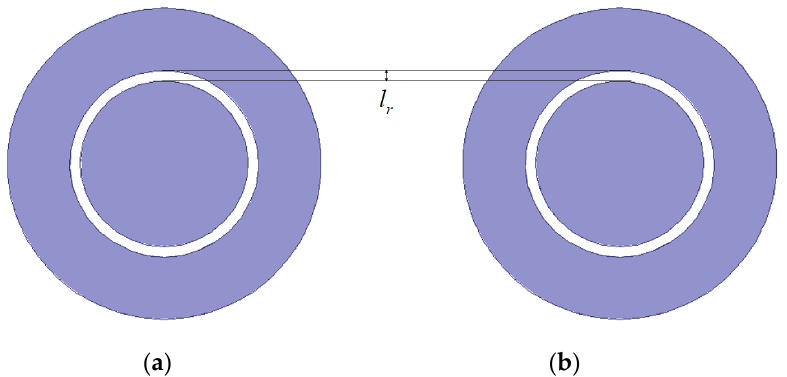
Figure 17. B-field distribution and high core loss potential areas: ( a ) Primary core; ( b ) Secondary core.